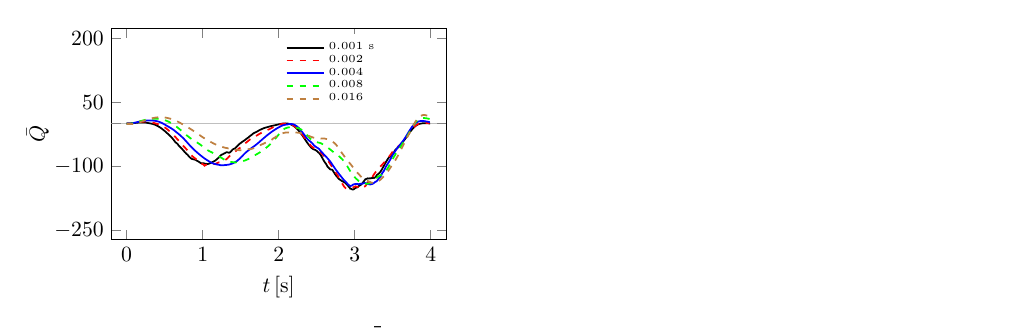
Figure 7. Influence of computational mesh on